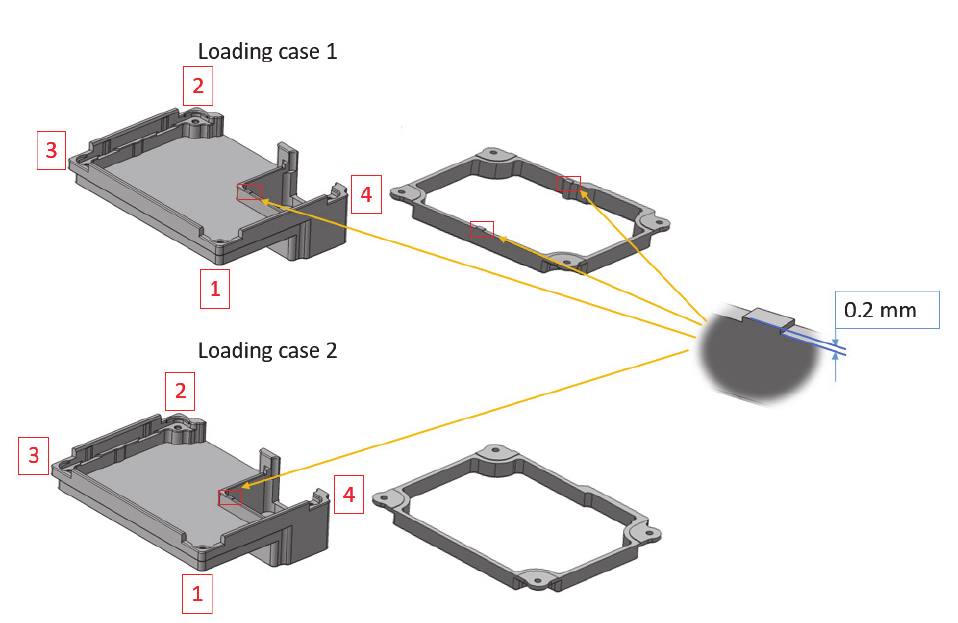
Figure 3: Bumps arrangement (Loading case 1: cover with two bumps and Loading case 2: cover without bumps).